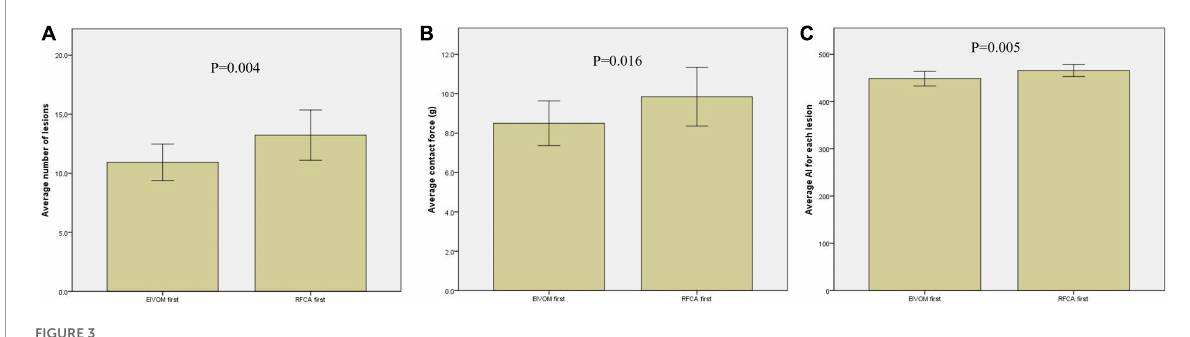
P = 0.01). ROC analysis showed the cut-off ethanol dose for predicting MIth block was 5.75 ml (sensitivity 50.8%